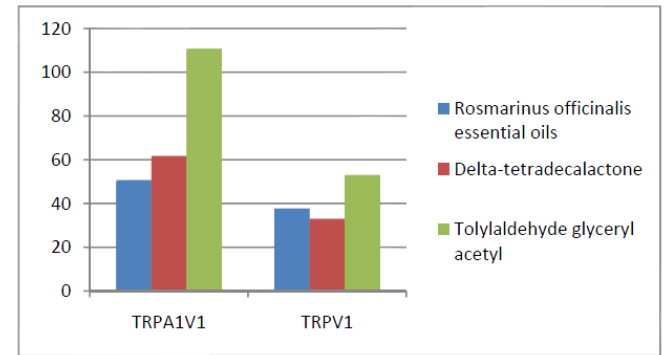
Figure 10. Examples of compounds that activate TRPV1 < TRPA1V1, but not